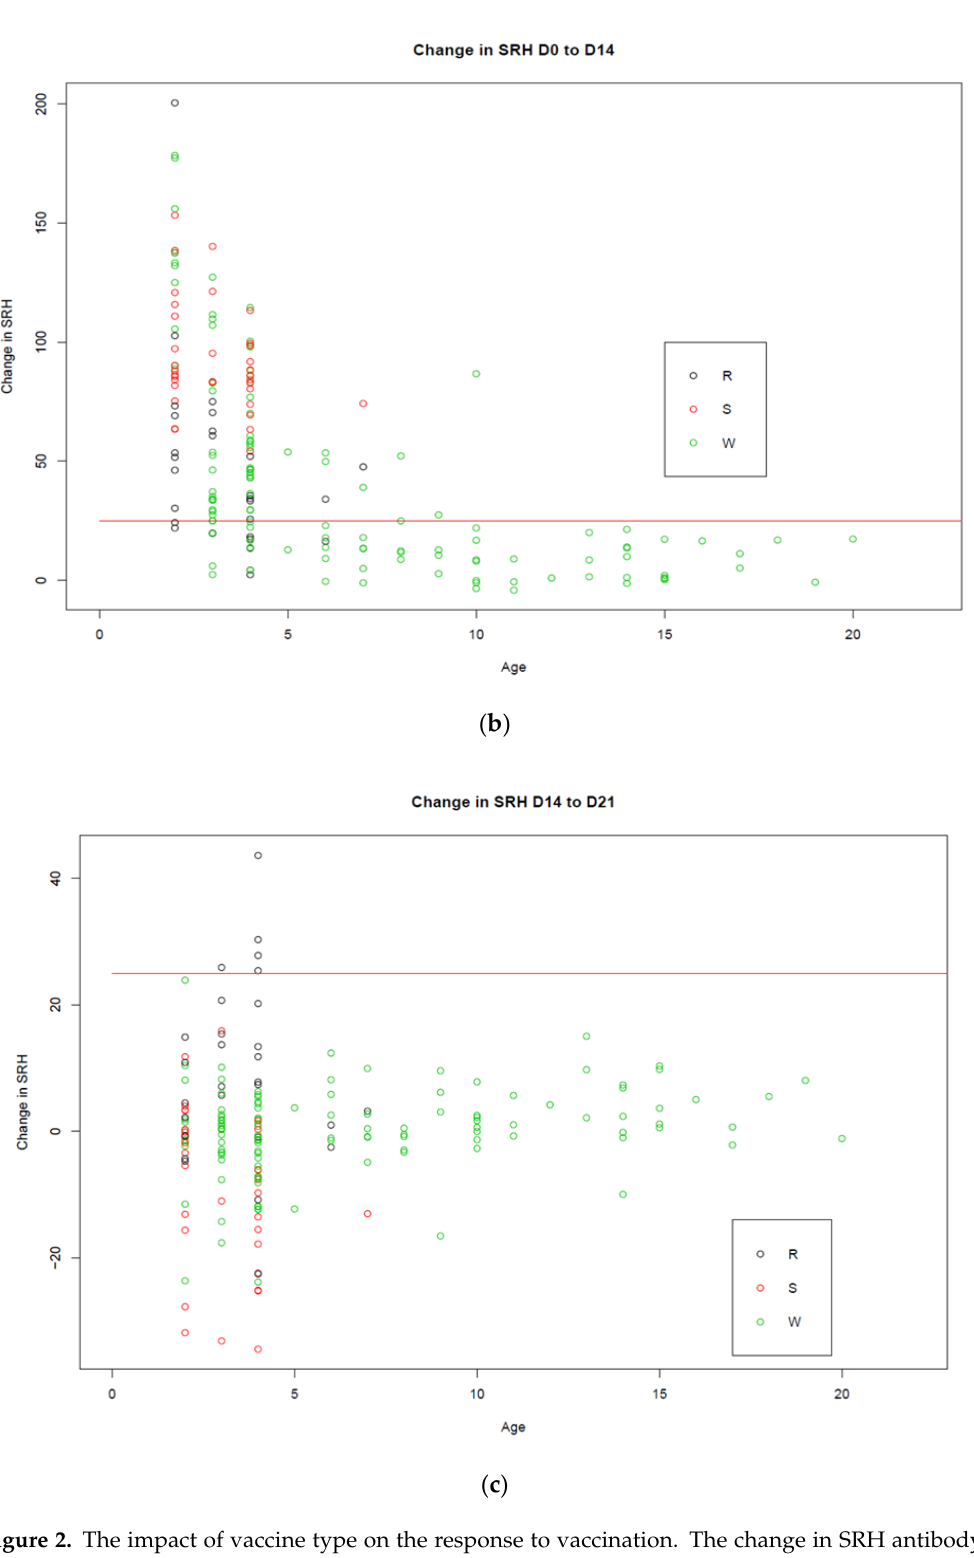
Figure 2. The impact of vaccine type on the response to vaccination. The change in SRH antibody titres between days 0 and 7 ( n = 192), days 0 and 14 ( n = 188), and days 14 and 21 ( n = 182) by age is represented in ( a – c ), respectively. The black circles represent the horses vaccinated with a recombinant vaccine (R), the red circles represent the horses vaccinated with a subunit vaccine (S), and the green circles represent horses vaccinated with whole inactivated vaccine (W). The red horizontal line is drawn at 25 mm 2 , as a rise of ≥25 mm 2 is considered significant (i.e., a seroconversion).